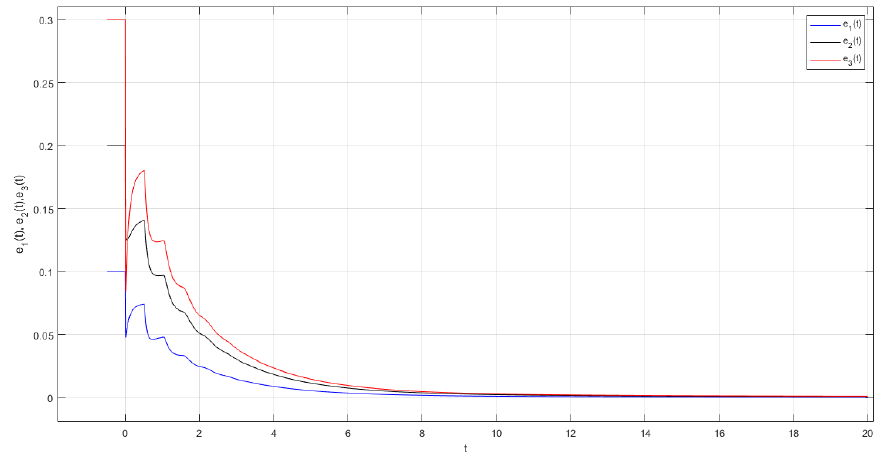
Figure 4. Bipartite leaderless synchronization of signed graph with eight vertices.